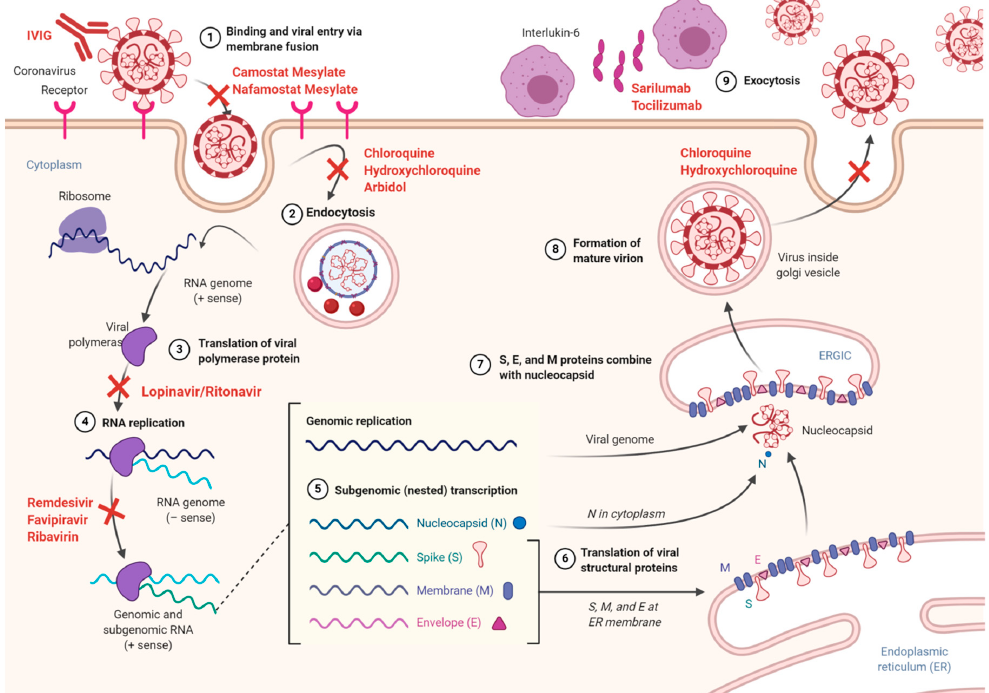
Figure 2. The life cycle of SARS-CoV-2 and potential mechanisms of action of drugs. The virus lifecycle starts when the S protein binds to its cellular receptor angiotensin converting enzyme II (ACE2). Following a conformation change in the S protein, the viral envelope fuses with the cell membrane. After endocytosis, the RNA of SARS-CoV-2 is released to the cytoplasm. Genomic RNA, which is positive sense, is translated into the viral polyproteins pp1a and 1ab. The polymerase produces a series of subgenomic mRNAs and translates the relevant viral proteins. In the endoplasmic reticulum (ER) and Golgi, viral proteins and genome RNA are assembled into virions and transported via vesicles and released out of the cell. ERGIC (ER–Golgi intermediate compartment). Site of action for each therapeutic candidate is shown with red cross.